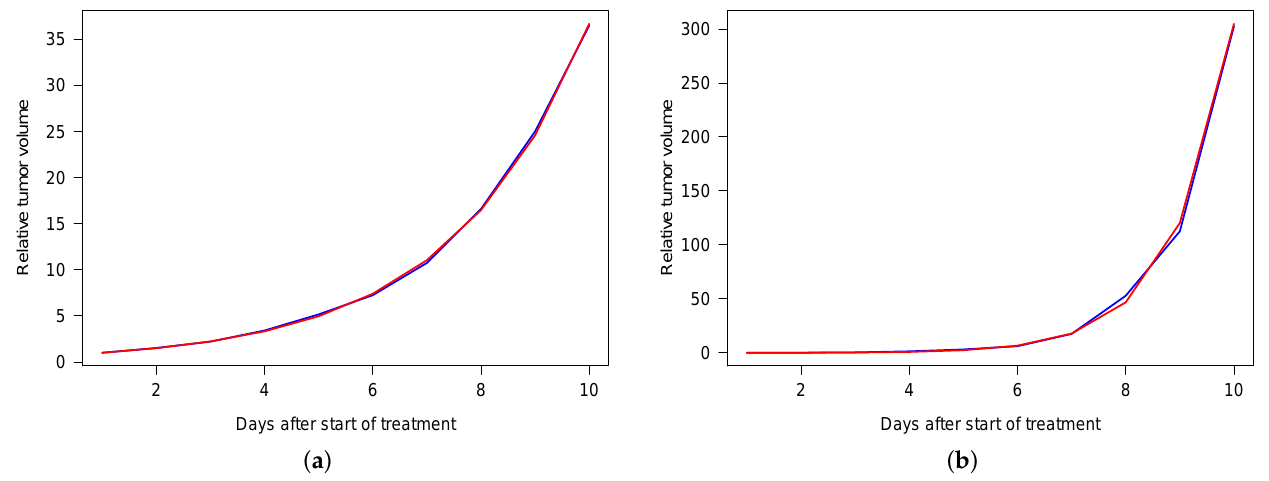
Figure 5. Mean ( a ) and variance ( b ) of simulated sample paths (in blue) and the fitted model (in red) for σ =